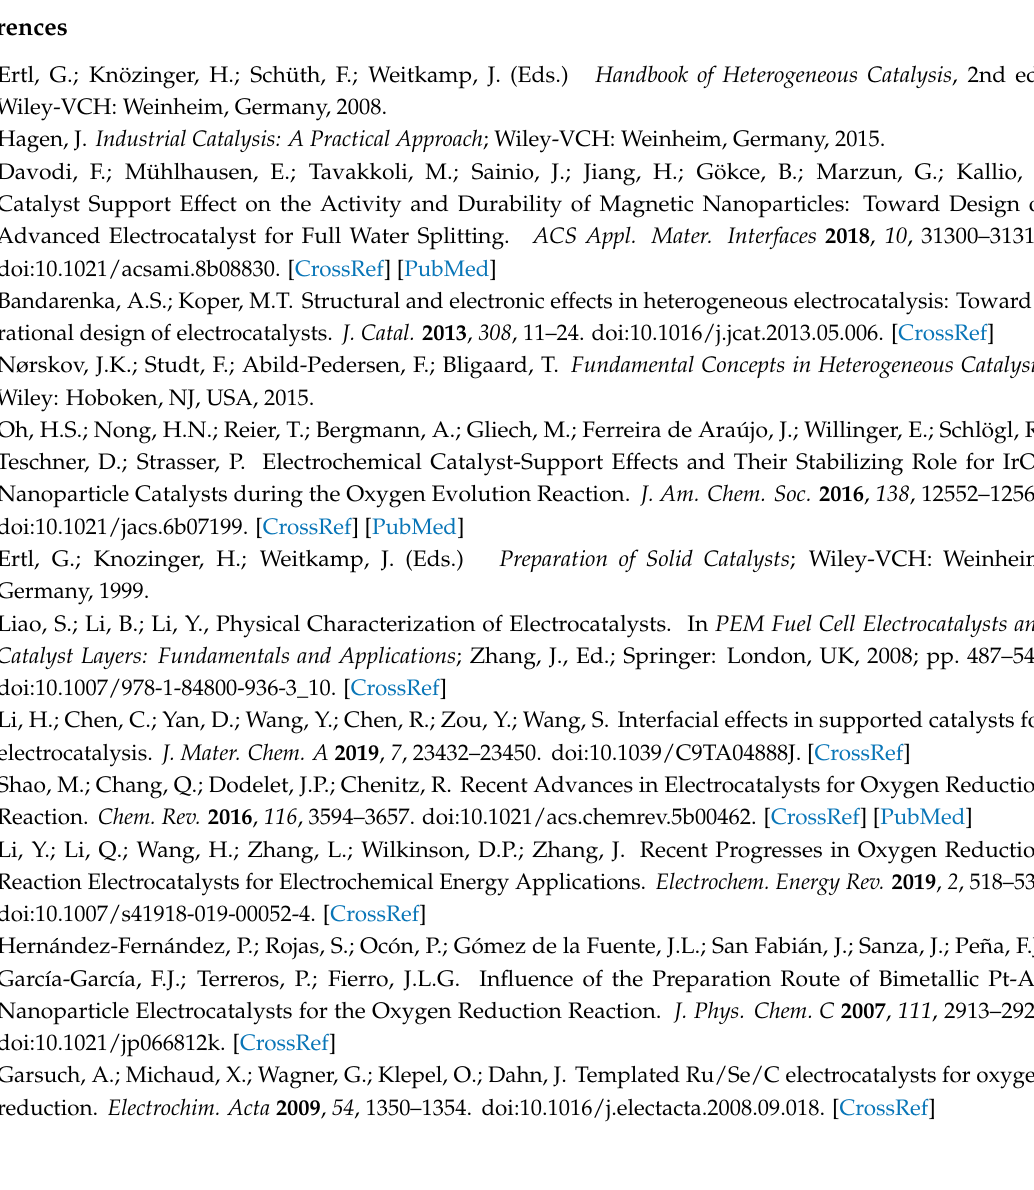
s1, Figure S1: SEM images of sample “Au”, Figure S2: Additional EDX map of sample “Au”, Figure S3: STEM HAADF image of sample “Au”, Figure S4: SEM images of sample “Au/Pt”, Figure S5: Additional EDX map of sample “Au/Pt”, Figure S6: EDX linescan of the sample “Au/Pt”, Figure S7: Additional EDX map of sample “Ru/Ti-1”, Figure S8: STEM-EDX map of sample “Ru/Ti-1”, Figure S9: EDX spectra extracted from the different layers of the sample “Ru/Ti-1”, Figure S10: Additional EDX map of sample “Ru/Ti-3”, Figure S11: XP spectra of sample “Ru/Ti-3”, Figure S12: Cyclic voltammograms of all investigated